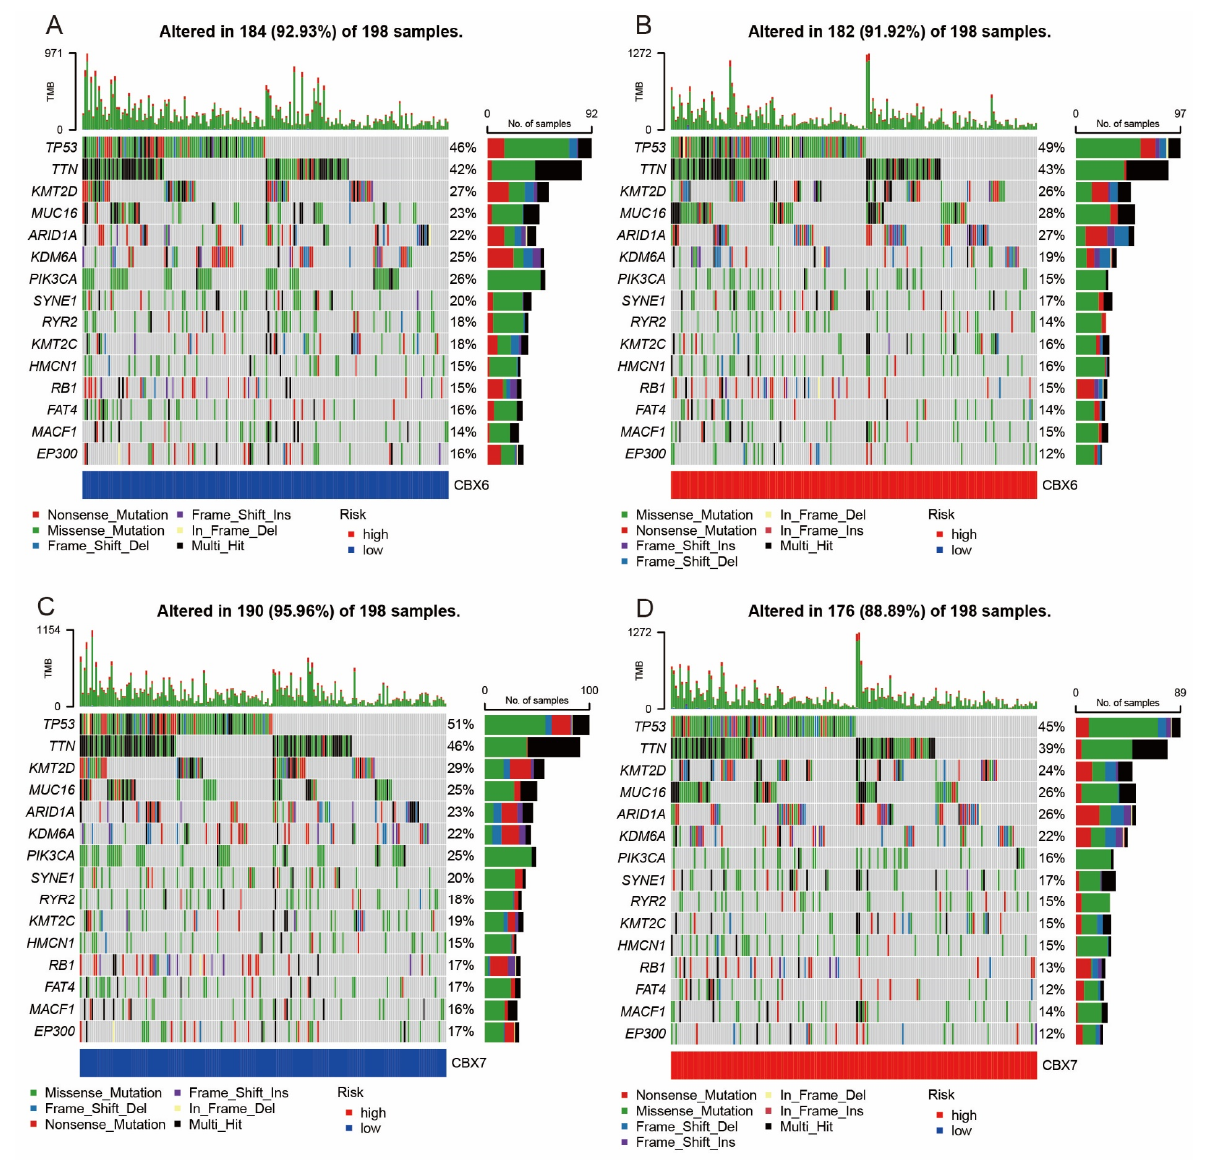
Figure 6. Waterfall diagrams illustrating somatic mutation properties of CBX6 and CBX7. ( A ) CBX6 low-expression group. ( B ) CBX6 high-expression group. ( C ) CBX7 low-expression group. ( D ) CBX7 high-expression group.